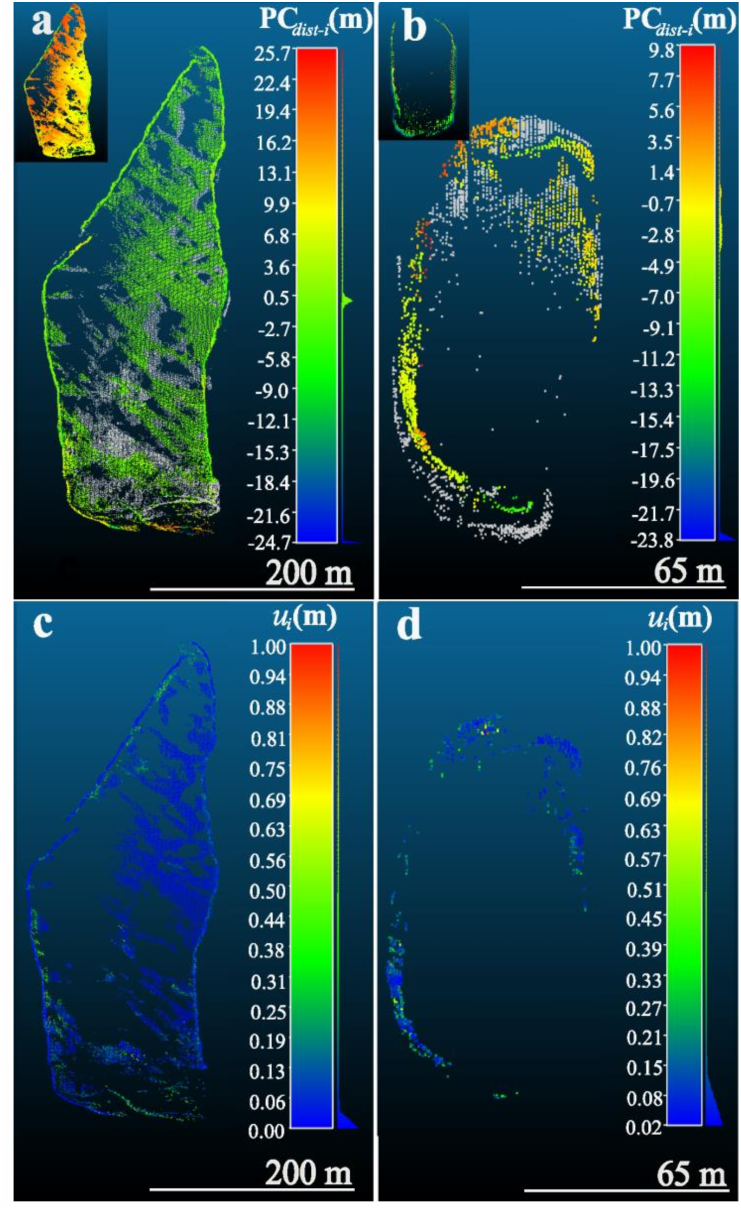
Figure 7. M3C2 algorithm output for TLS-generated point cloud comparisons. ( a , b ) show the distance between triplicate point clouds (PC dist-i ) for i1 ( a ) and i2 ( b ), respectively. Gray points represent ‘NA’ values where corresponding points between the two clouds did not exist. The uncertainty ( u i ) in these distances at the 95% confidence level is illustrated in ( c , d ) for i1 and i2, respectively. Histograms to the right of the colour scale bar depict the frequency of the corresponding values. Point size was augmented in comparison to Figure 6 to aid visualization. The insets in ( a , b ) contain example point clouds of the respective ice island before M3C2 point cloud differencing. Inset colours represent height values where red represents the higher elevations. Survey line misalignment can be seen in ( a ) and is an artifact of the point cloud correction procedure. Note the variation in scale between panels and in comparison to Figure